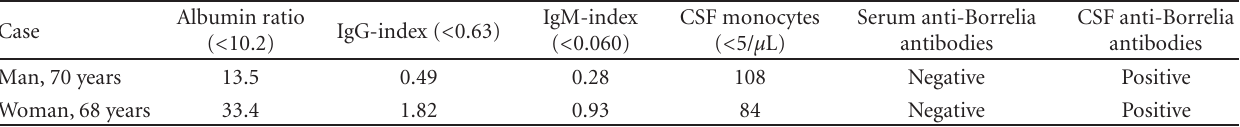
Table 1: Biochemical findings in the cerebrospinal fluid of two patients with cognitive problems and Lyme